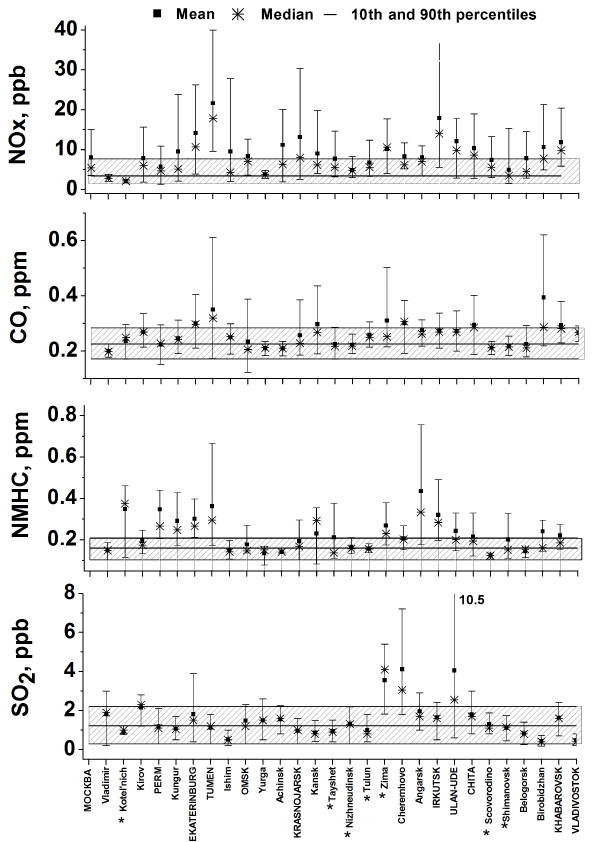
Figure 6. Inorganic impurities in Russian cities along the Trans- Siberian Railway. The cities with a population from 250000 to 1 million or more are shown in capital letters, and the cities with a population from 50000 to 250000 in lowercase. Asterisks show the cities with a population less than 50000. The cities are shown in accordance with their location along the railway. The shaded area represents mean, 10th and 90th percentiles calculated from the data measured in rural regions.